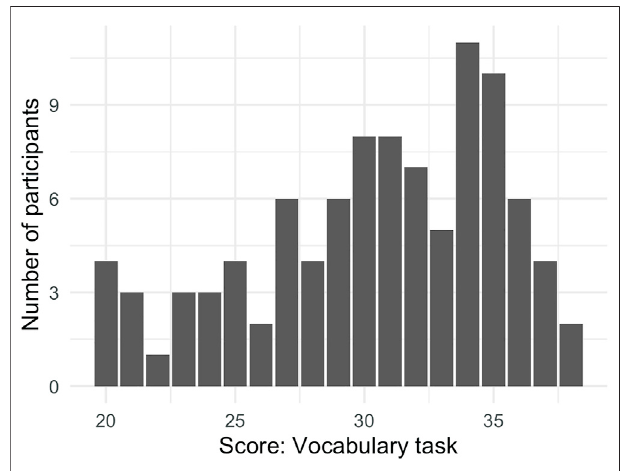
FIGURE 3 | Age of participants (self-reported). FIGURE 4 | Distribution of scores on the vocabulary